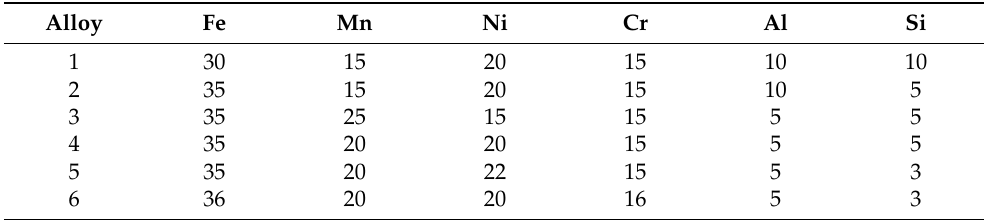
Table 1. The chemical composition of FeMnNiCrAlSi HEA alloys (at.%). Alloy Fe Mn Ni Cr